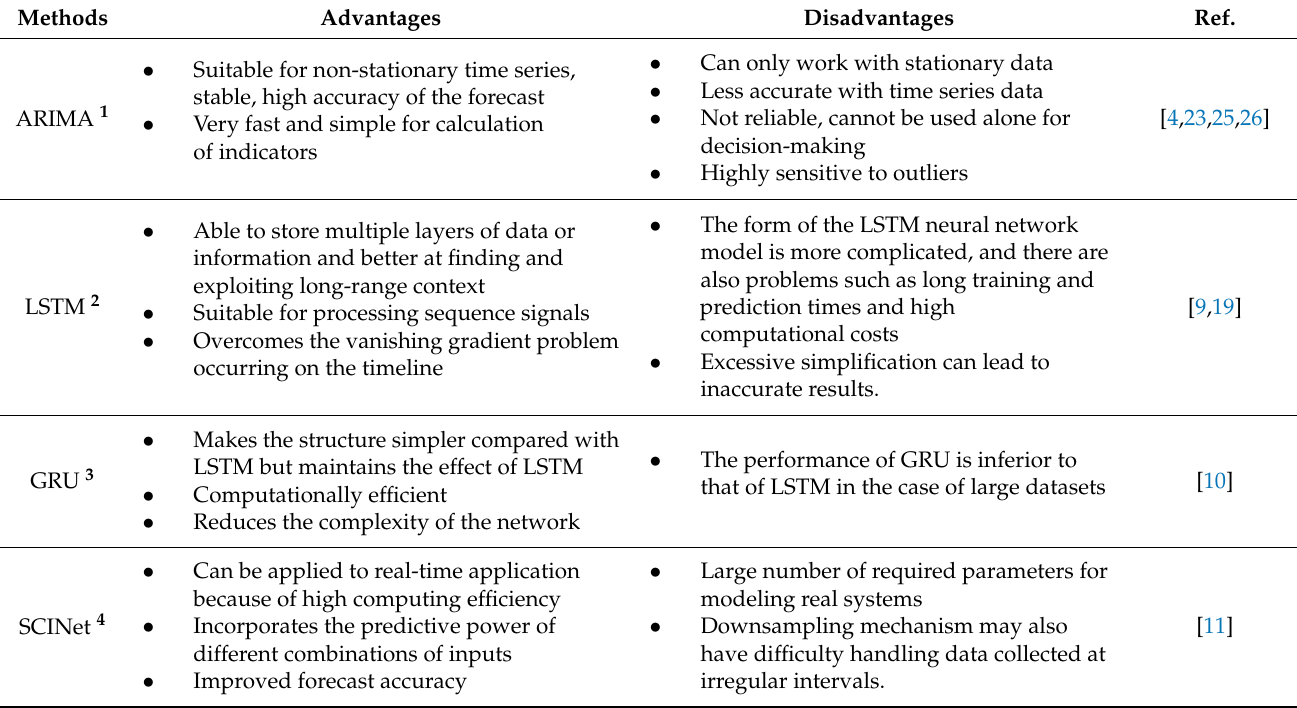
Table 1. Advantage and disadvantage for forecasting